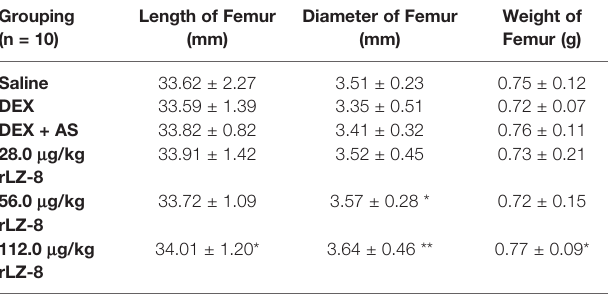
TABLE 1 | Description of 60 right femurs each